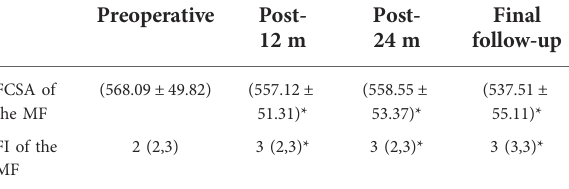
TABLE 3 Preoperative and postoperative paraspinal muscle parameters.